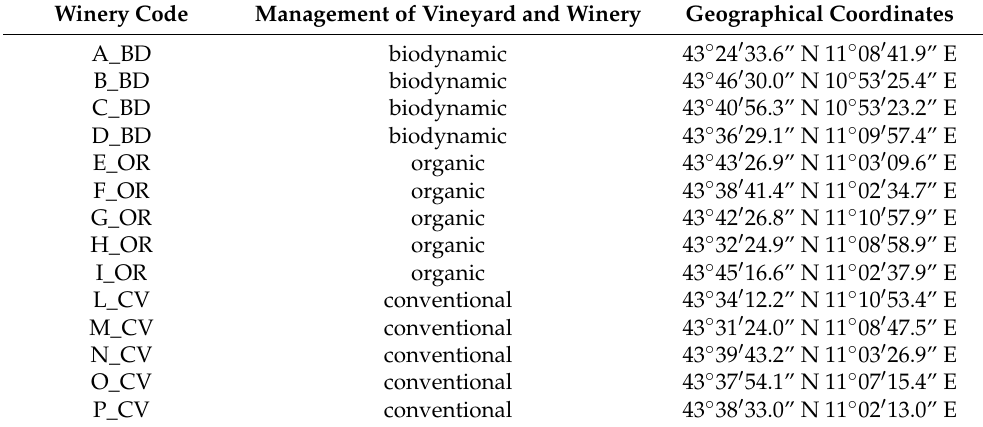
Table 1. Winery code, vineyard, and winery management, and geographical area coordinates. Winery Code Management of Vineyard and Winery Geographical